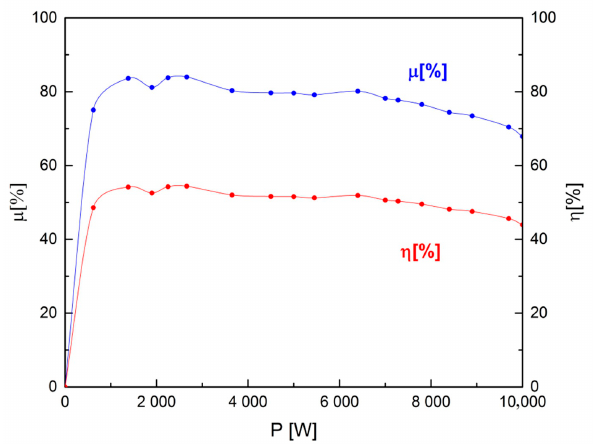
Figure 12. Electrical efficiency ε and hydrogen utilisation μ vs. electrical power produced by the PEMFC stack.